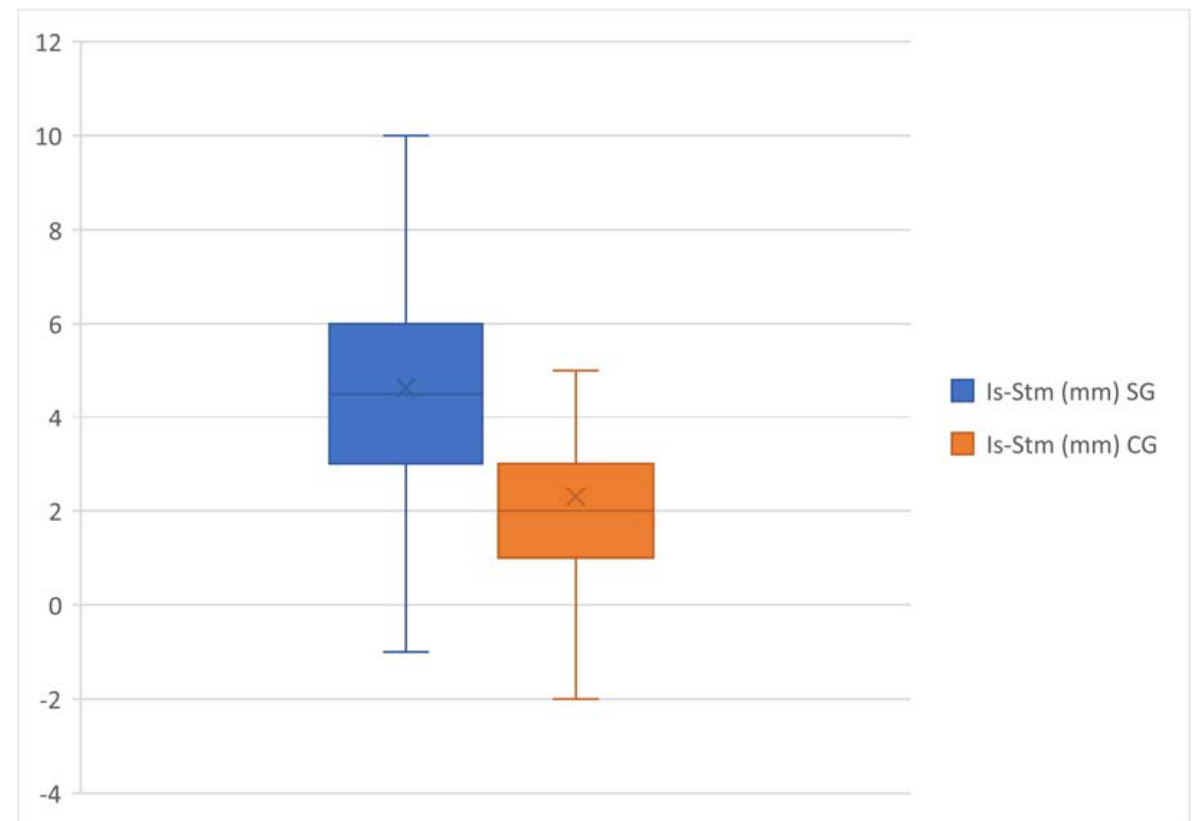
Figure 8. Is-Sts comparison in the study group and the control